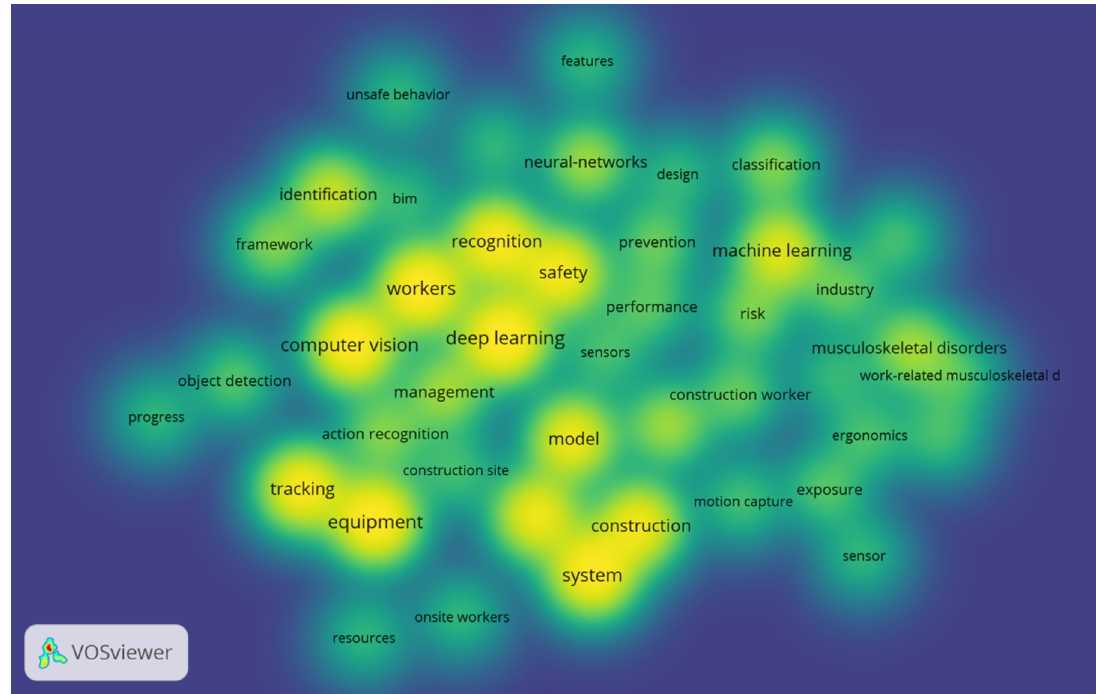
Figure 8. Keyword hotspot map.